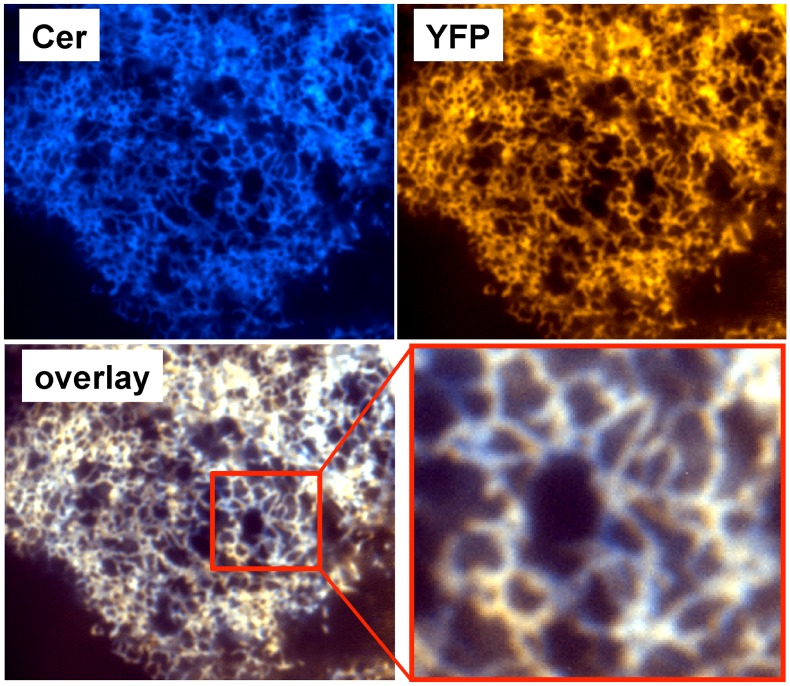
TIRF microscopy of AAV-293 cells expressing 2-color SERCA (509).Fluorescence was distributed in a reticulated pattern consistent with ER localization.